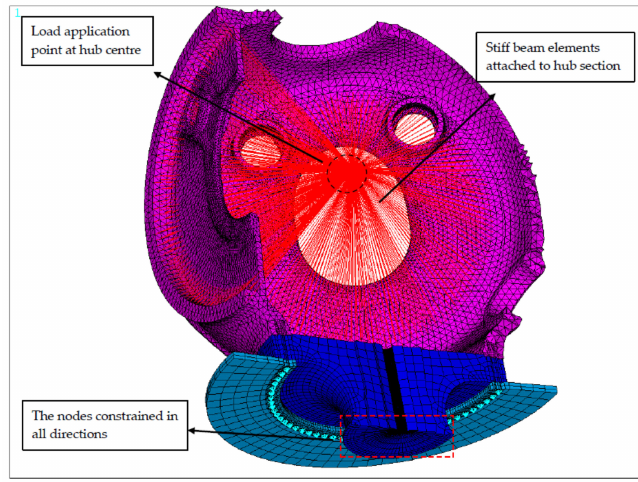
Figure 7. Boundary conditions.